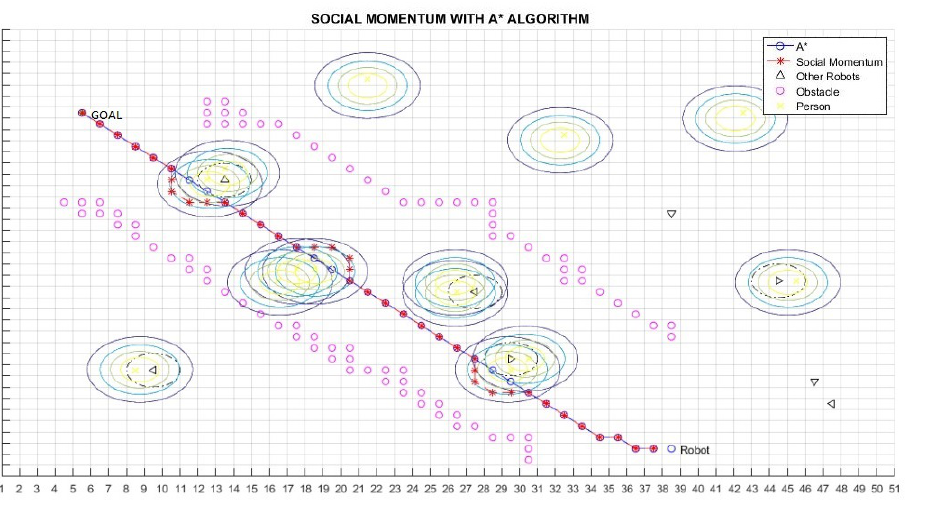
Figure 20. Path 4—Example 1 of navigation considering humans and robots in groups.